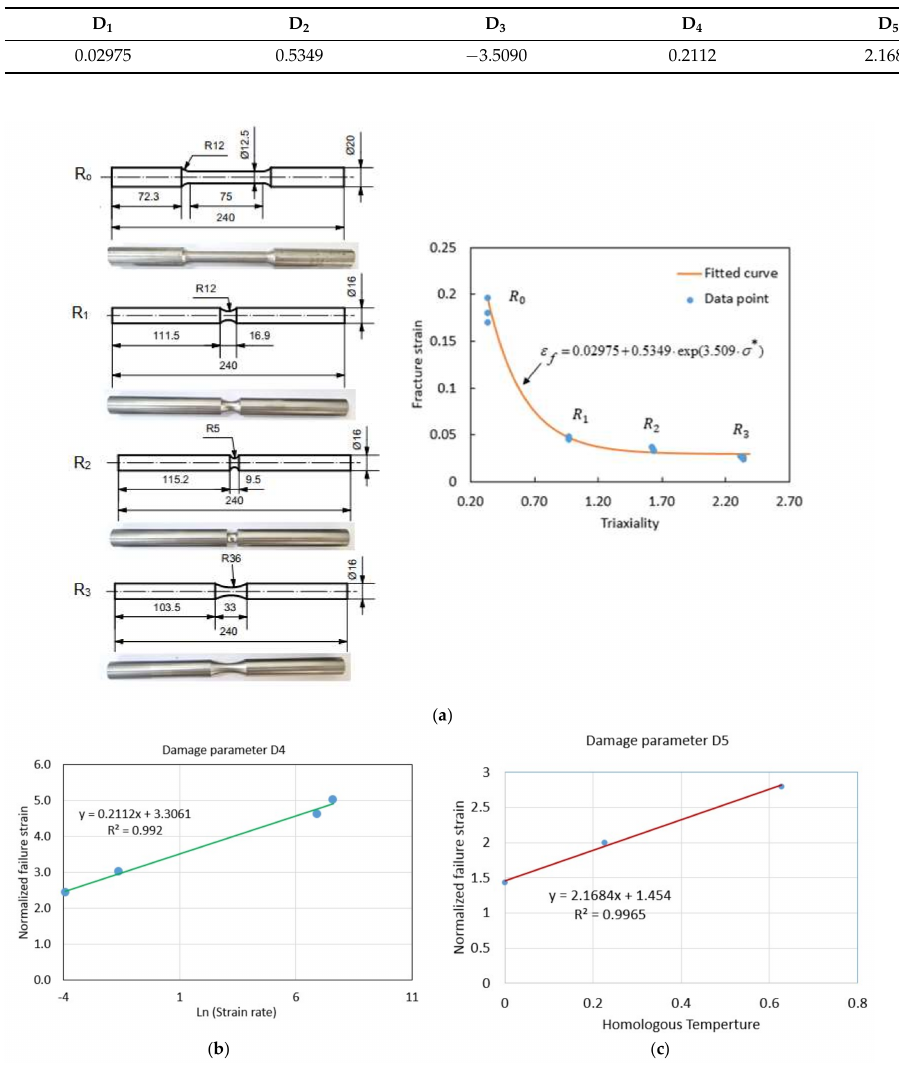
Figure 2. The equivalent fracture strain is based on ( a ) stress triaxility, ( b ) strain rate, and ( c )